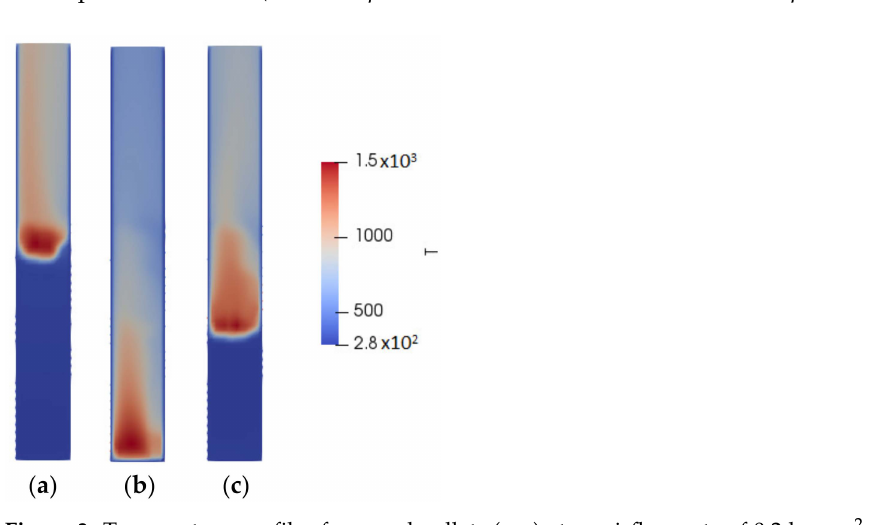
Figure 3. Temperature profiles for wood pellets (wp) at an airflow rate of 0.2 kg.m − 2 s − 1 , at three different moments: ( a ) 1000 s; ( b ) 3500 s and ( c ) 7000 s. Temperatures are measured on the Kelvin scale. Table 3. Relative error (%E) of values of simulated ignition front velocity (F. Velocity) and maximum temperature